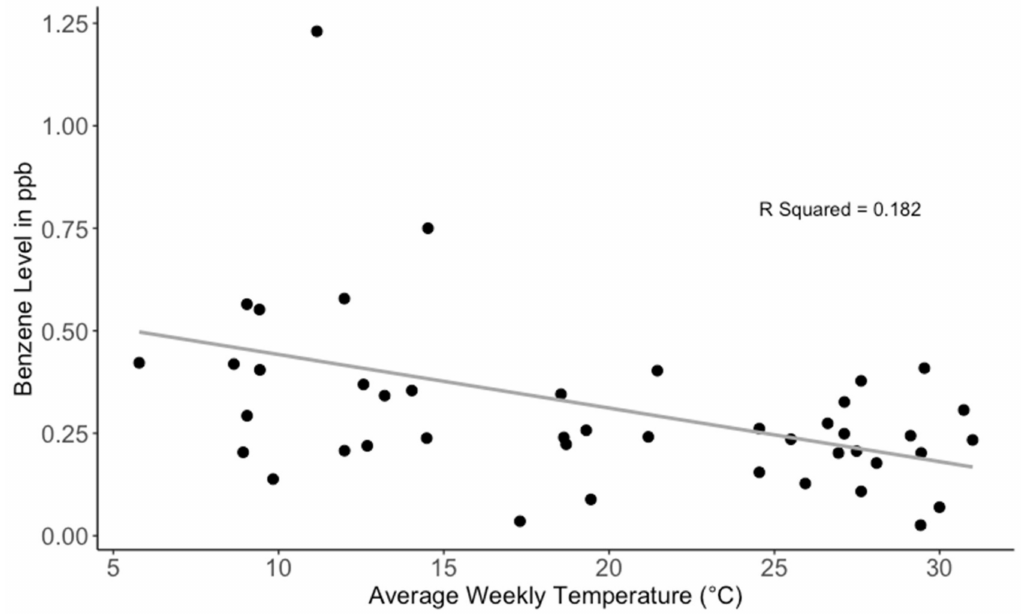
Figure 8. Relationship between 2–m air temperature (at a 30–km distant weather station) and benzene levels. The significant negative correlation ( p = 0.004) is likely due to seasonal boundary layer e ff ects, which co-varies with wind